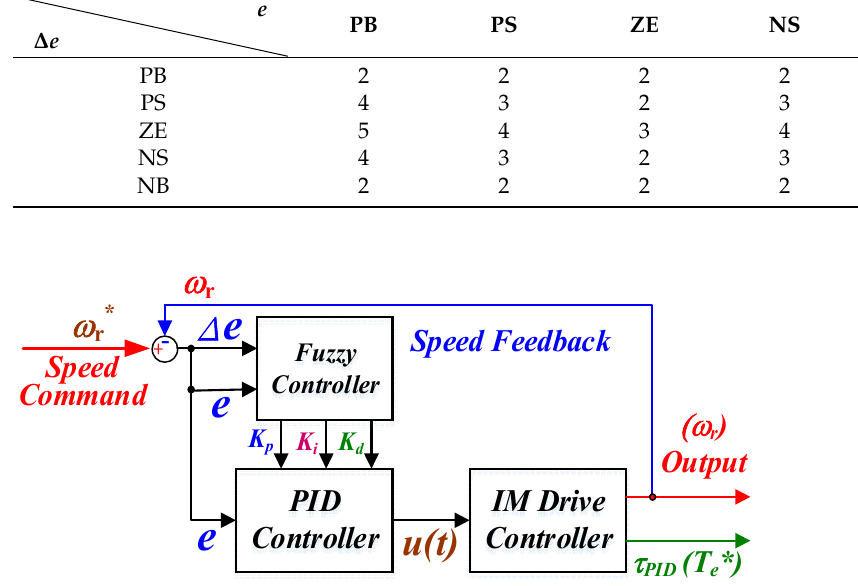
Table 6. Rules for the five-stage fuzzy controller.